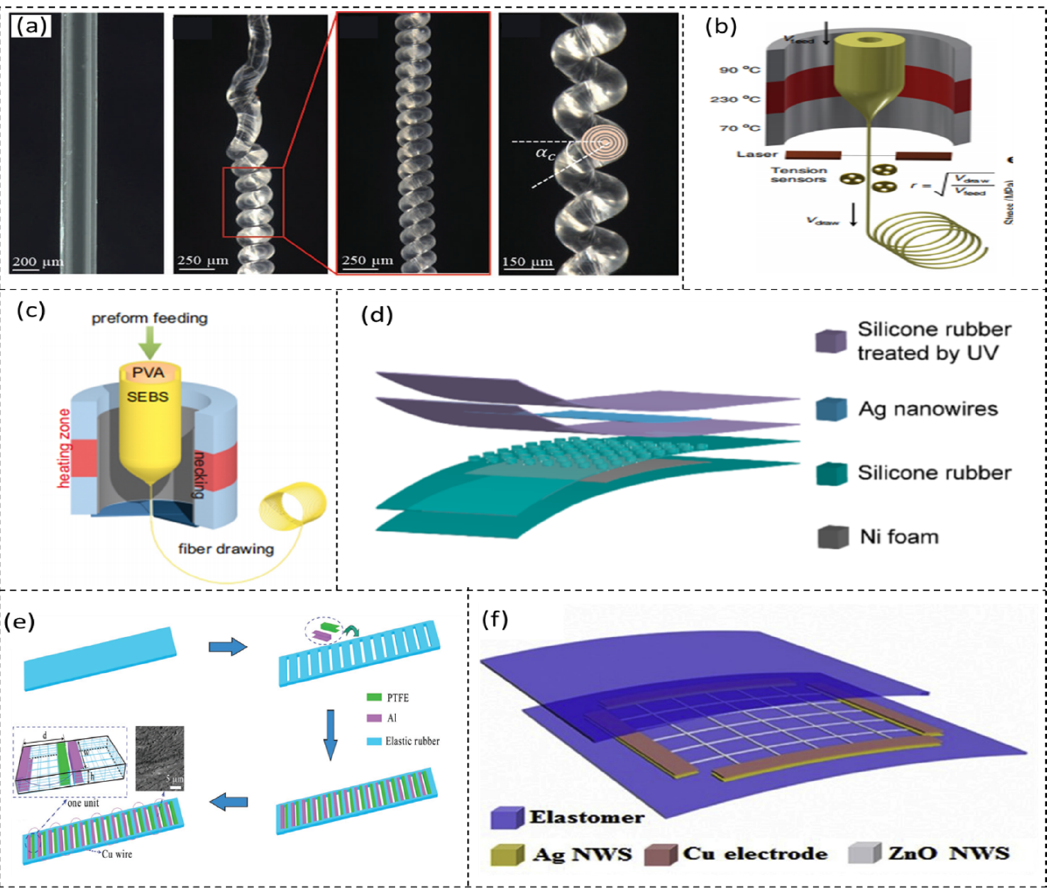
Figure 1. ( a ) Photos of PVDF melt-spun fiber. Reprinted from Ref. [41]. ( b ) Schematic of thermal drawing process. Reprinted from Ref. [42]. ( c ) Schematic of the fiber drawing process. Reprinted from Ref. [44]. ( d ) Schematic of DS-TENG. Reprinted with permission from Ref. [45]. Copyright 2019 American Chemical Society. ( e ) Schematic of SF-TENG. Reprinted with